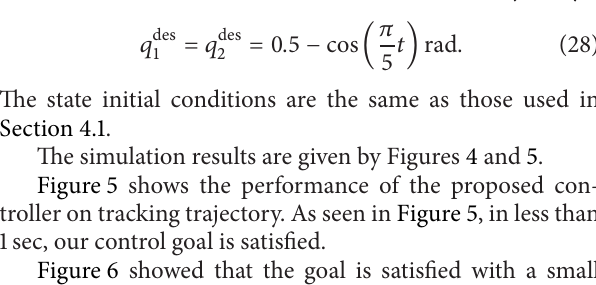
Motor 2 voltage in various joint